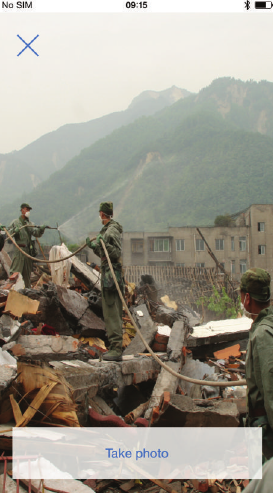
Figure 17: Screenshot of picture